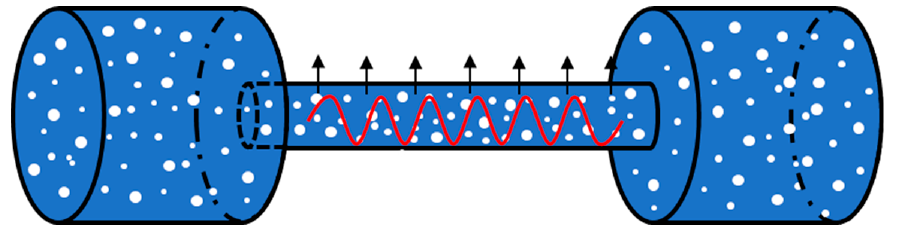
Figure 5. Photoacoustic signal in liquid photoacoustic cell. When the modulation frequency of the laser is not greater than 1 kHz, then l = 0, and the intensity of the photoacoustic signal can be expressed as: